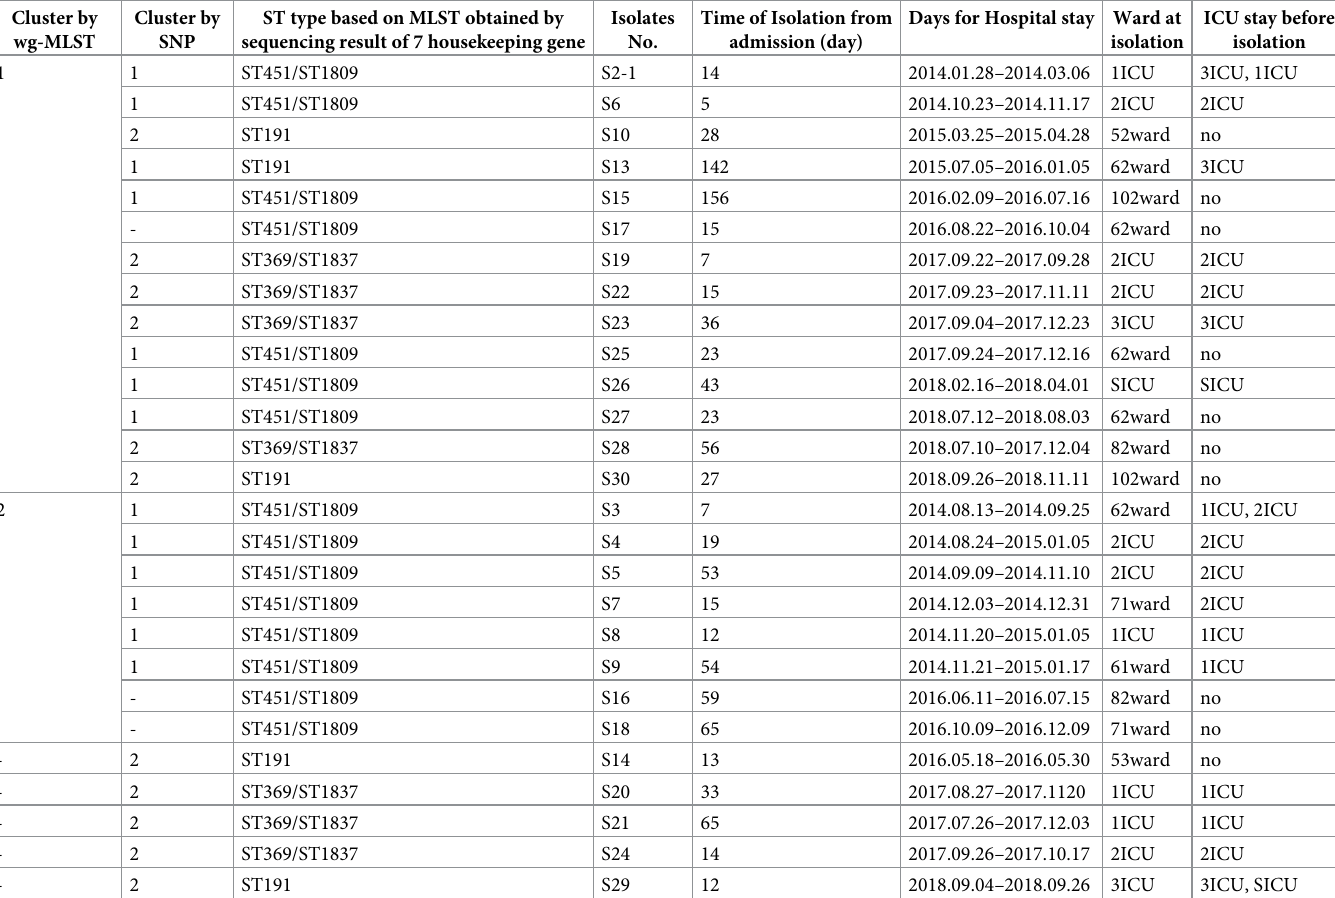
Table 5. Description of 22 patients and isolates associated with two clusters of colistin-resistant A . baumannii . Cluster by Cluster by ST type based on MLST obtained by wg-MLST SNP sequencing result of 7 housekeeping gene